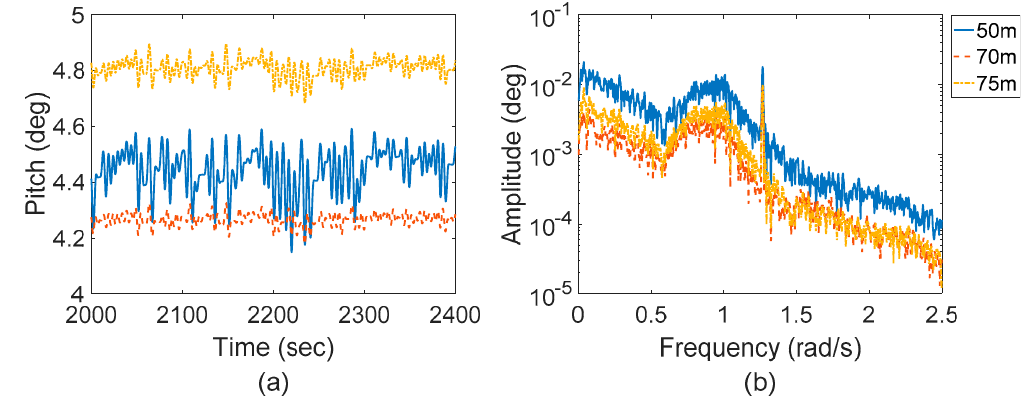
Figure 7. Dynamic response of pitch angle. ( a ) Time histories of pitch angle ( b ) Response spectra of pitch angle.